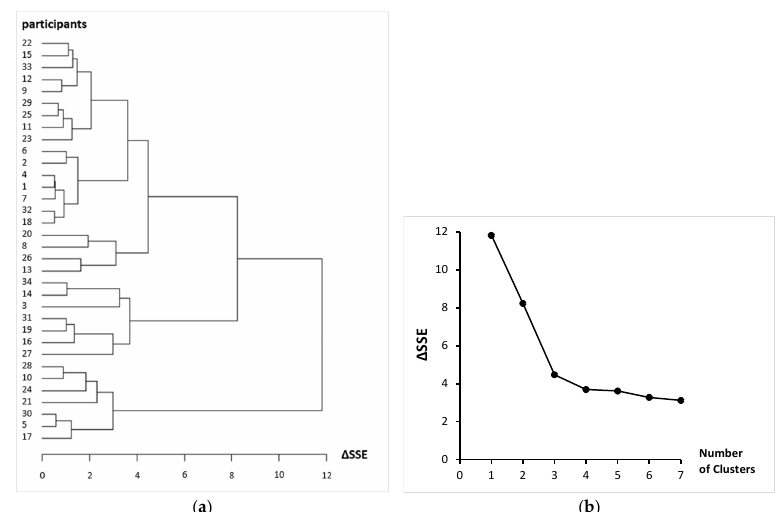
Figure 6. Mean crossing onset time (COT) for all yielding test conditions. Error bars: ±1 SE.